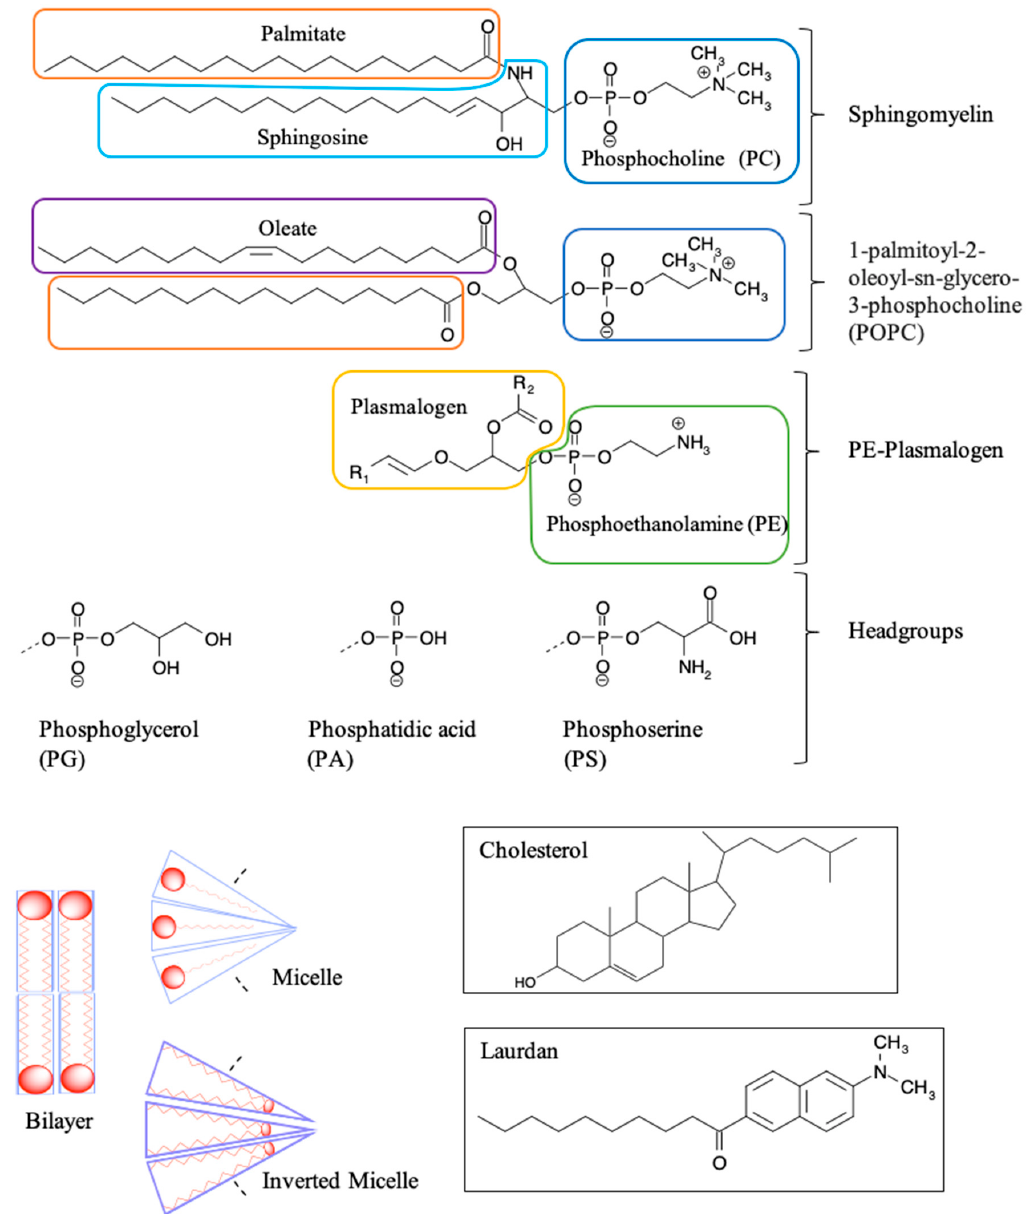
Figure 6. Structures of acyl chains and head groups commonly found in lipid membranes, as well as the structures of cholesterol and Laurdan. (R 1 , R 2 = chain lengths on plasmalogen vary). Packing arrangement of phospholipids, based on acyl-chain / head group composition. Cylinder-shaped phospholipids form bilayers and wedge-shaped phospholipids form micelles / inverted micelles.